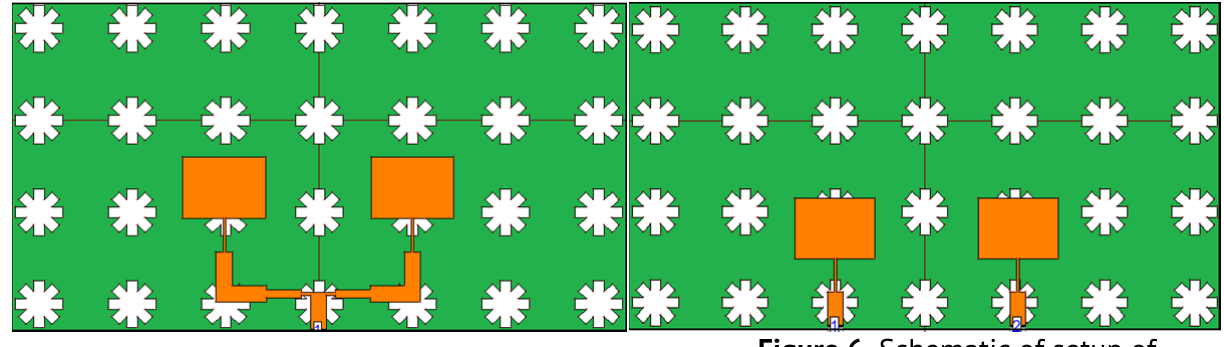
Figure 6. Schematic of setup of Figure 5. Schematic of microstrip microstrip antenna array with star slot EBG antenna array with star slot EBG structure. structure for mutual coupling measurement.